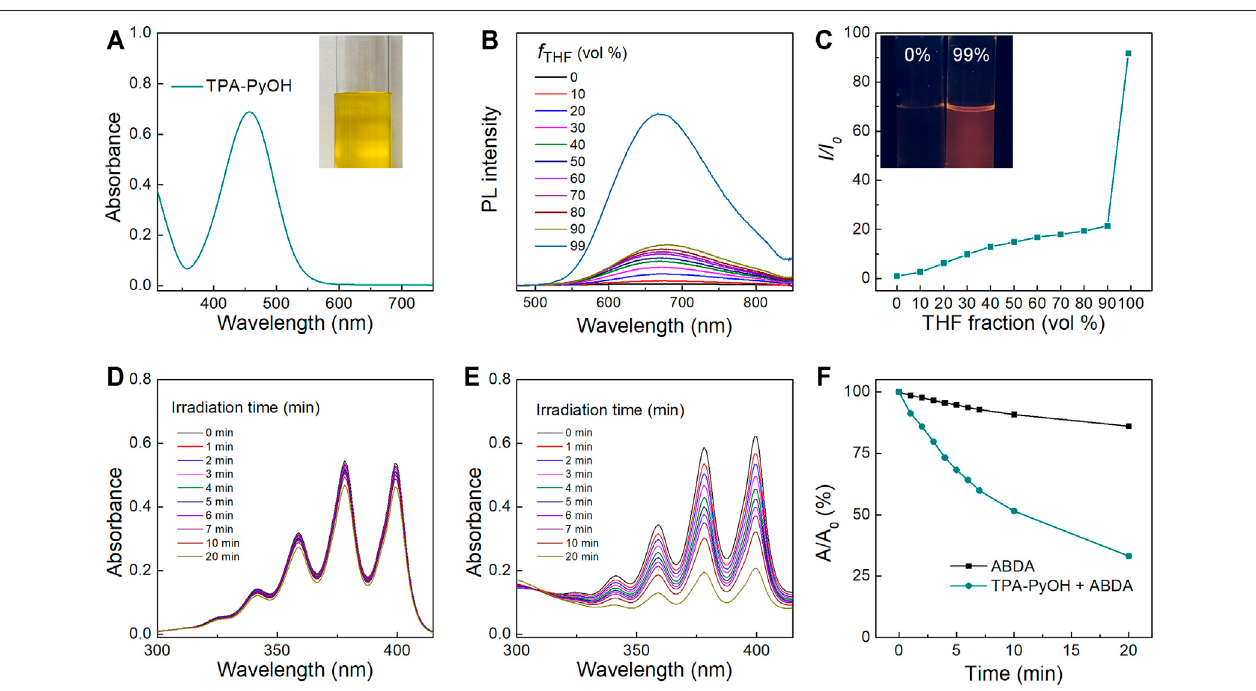
FIGURE 2 | (A) UV-vis absorption spectrum of TPA-PyOH and its representative photograph of aqueous solution. (B) PL spectra of TPA-PyOH (10 mM) in water/ THFmixtureswithdifferentTHFvolumefractions( f THF ). (C) Theplotoftheemissionmaximumandtherelativeemissionintensity( I/I 0 )versusthecompositionofthewater/ THF mixtures of TPA-PyOH. Inset: fl uorescence photographs of TPA-PyOH in the pure water and in water/THF mixtures with 99% THF fractions under 365 nm UV irradiation. (D) AbsorptionspectraofABDA(50 μ M)uponwhitelightirradiationfordiversedurations. (E) AbsorptionspectraofABDAinthepresenceofTPA-PyOH (20 μ M)uponwhitelightirradiationfordiversedurations. (F) PlotoftherelativeabsorbanceofABDAwithwhitelightirradiationunderdifferentconditions(A 0 andAarethe absorbance of ABDA at 378 nm before and after